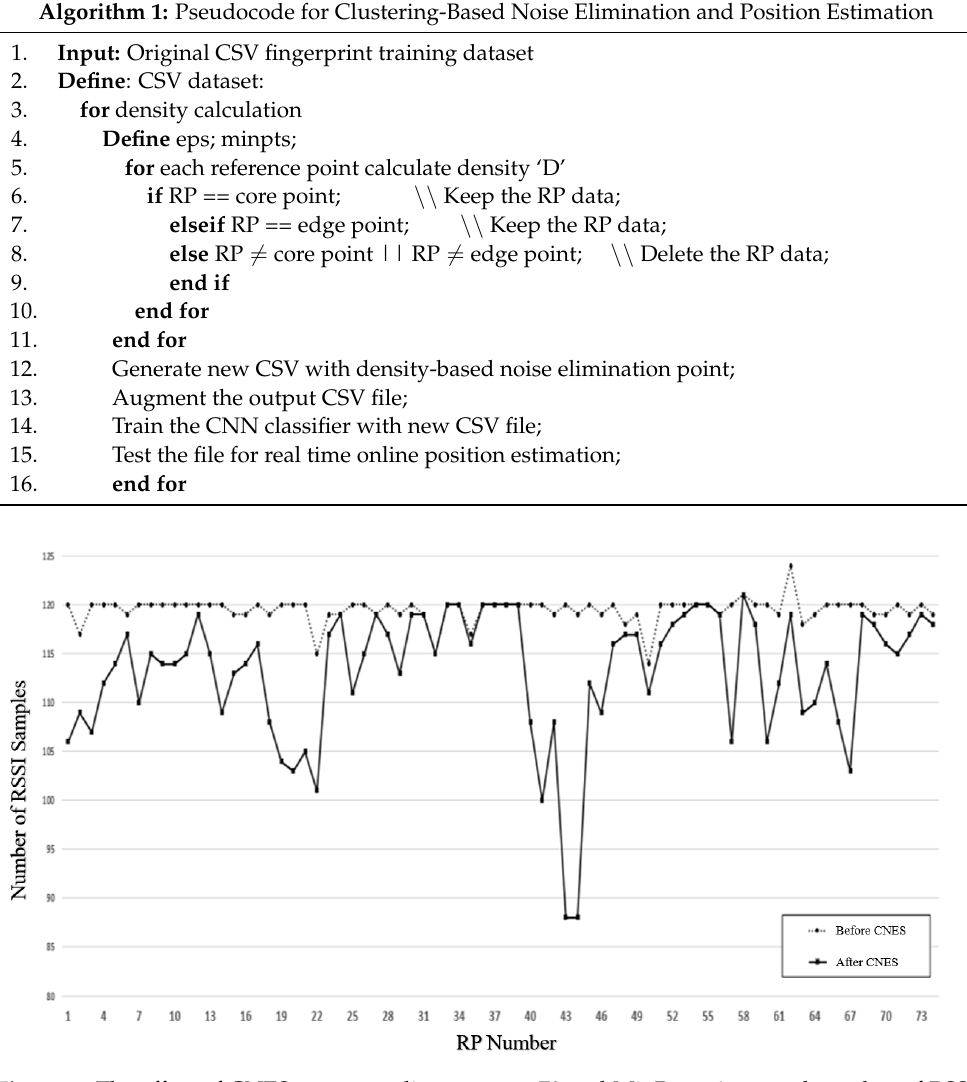
Figure 9. The effect of CNES corresponding to eps = 70 and MinPts = 4 on total number of RSSI samples at each RP.